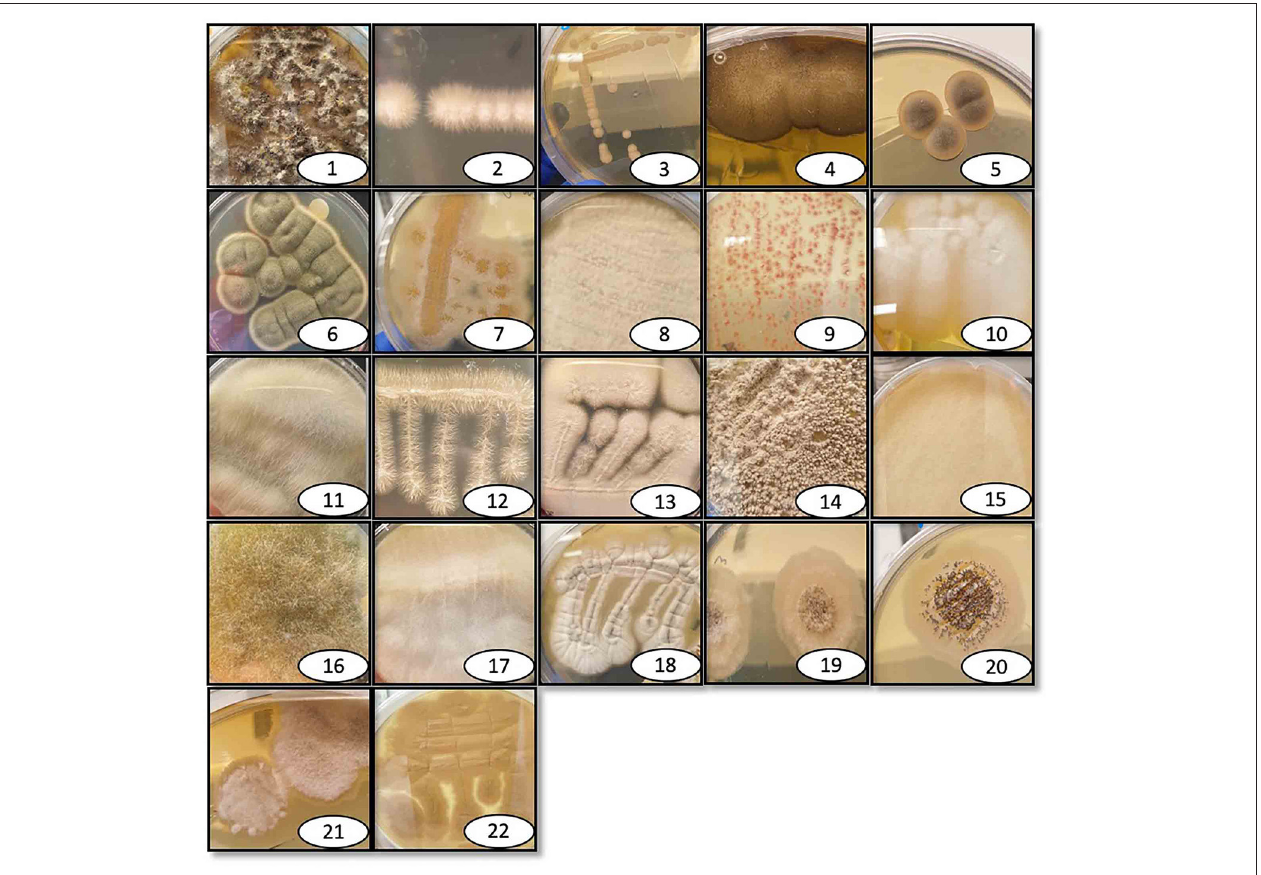
FIGURE 1 | Pictures of isolated and identified fungi. Individual photographs of the isolated fungi that are identified here, labeled with the reference number, and listed in Table 1 . The fungi were collected at various outdoor locations and maintained in the lab on either rich growth agar medium brain heart infusion or Sabouraud dextrose, depending on the fungal